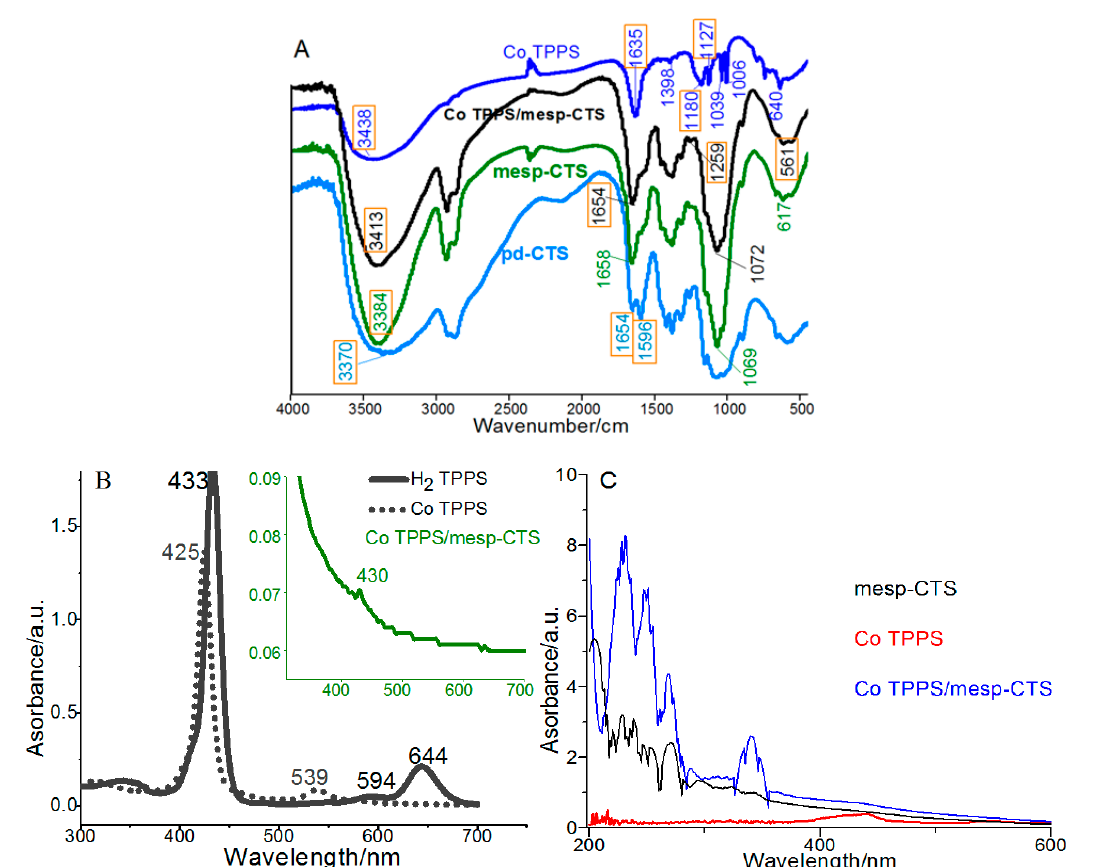
Figure 3. ( A ) Fourier transform infrared (FT-IR) spectra of Co TPPS/mesp-CTS (or Co TPPS/macp-CTS), Co TPPS, mesp-(or macp-)CTS and,powdered chitosan (pd-CTS), with an effective frequency range of 400–4000 cm; ( B ) ultraviolet-visible(UV-vis) spectra of an aqueous solution of H 2 TPPS ( ε = 5.3 × 10 L·mol cm) and Co TPPS ( ε = 2.7 × 10 L·mol cm) and an aqueous suspension of Co TPPS/mesp-CTS(or Co TPPS/macp-CTS) ( ε = 0.4 × 10 L·mol cm); and ( C ) UV-DRS (vis diffuse reflectance spectra) spectra of mesp-CTS(or macp-CTS), Co TPPS, and Co TPPS/mesp-CTS (or Co TPPS/macp-CTS).